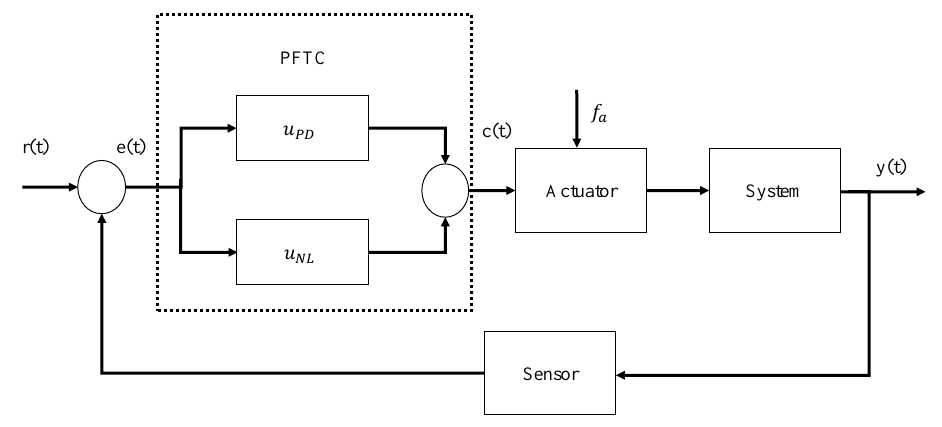
Figure 5. PFTC controller